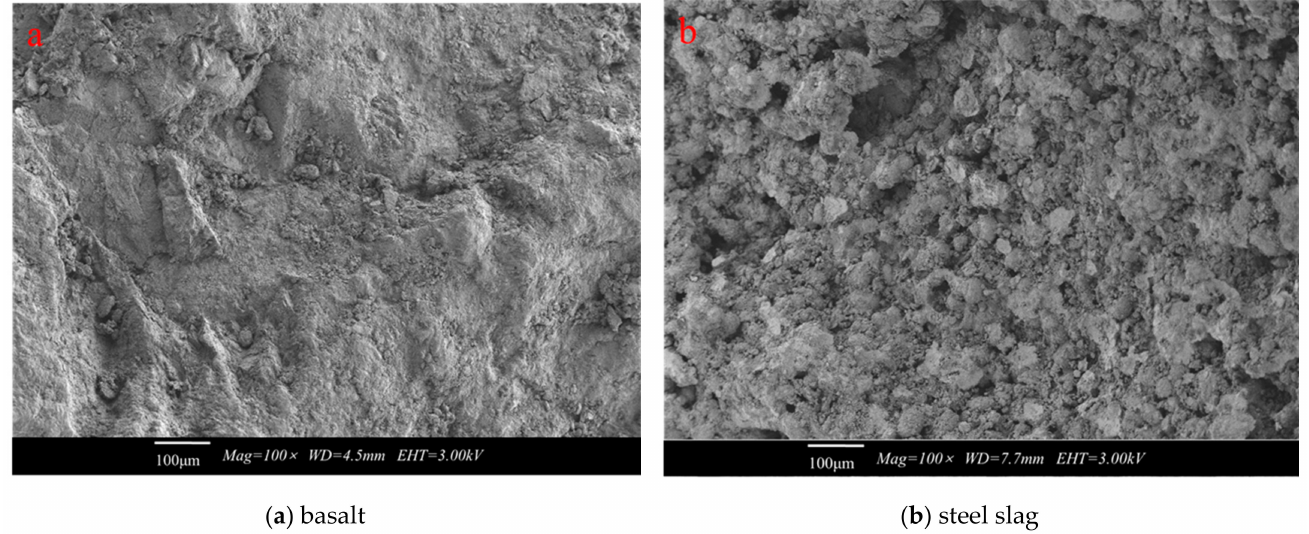
Figure 1. SEM images of different aggregates (2.36–4.75 mm). ( a ) basalt; ( b ) steel